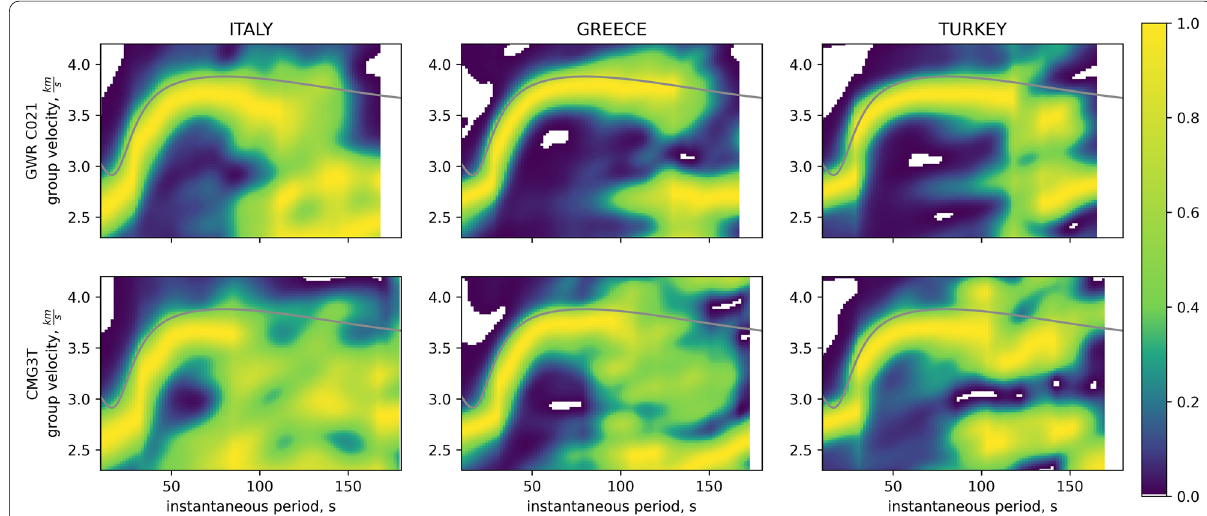
Fig. 4 Distribution maps of group‑velocity of fundamental‑mode Rayleigh waves for SG and BB of the Membach station calculated based on the Italy, Greece and Western Turkey earthquakes; the dispersion curve for the ak135 background model is shown as a solid grey